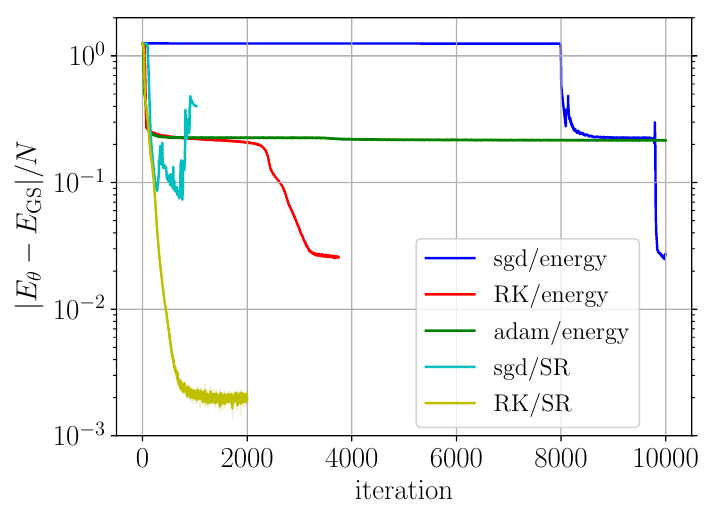
Figure 15: Variational energy density against the iteration number for different opti- mizers and cost functions. The system size is N = 6 × 6. The network architecture is / J = 0.5. The MC sample size is N = 10 5 . The data were listed in App. H, and J 2 1 MC produced from simulations using 1024 Haswell cores running for 48